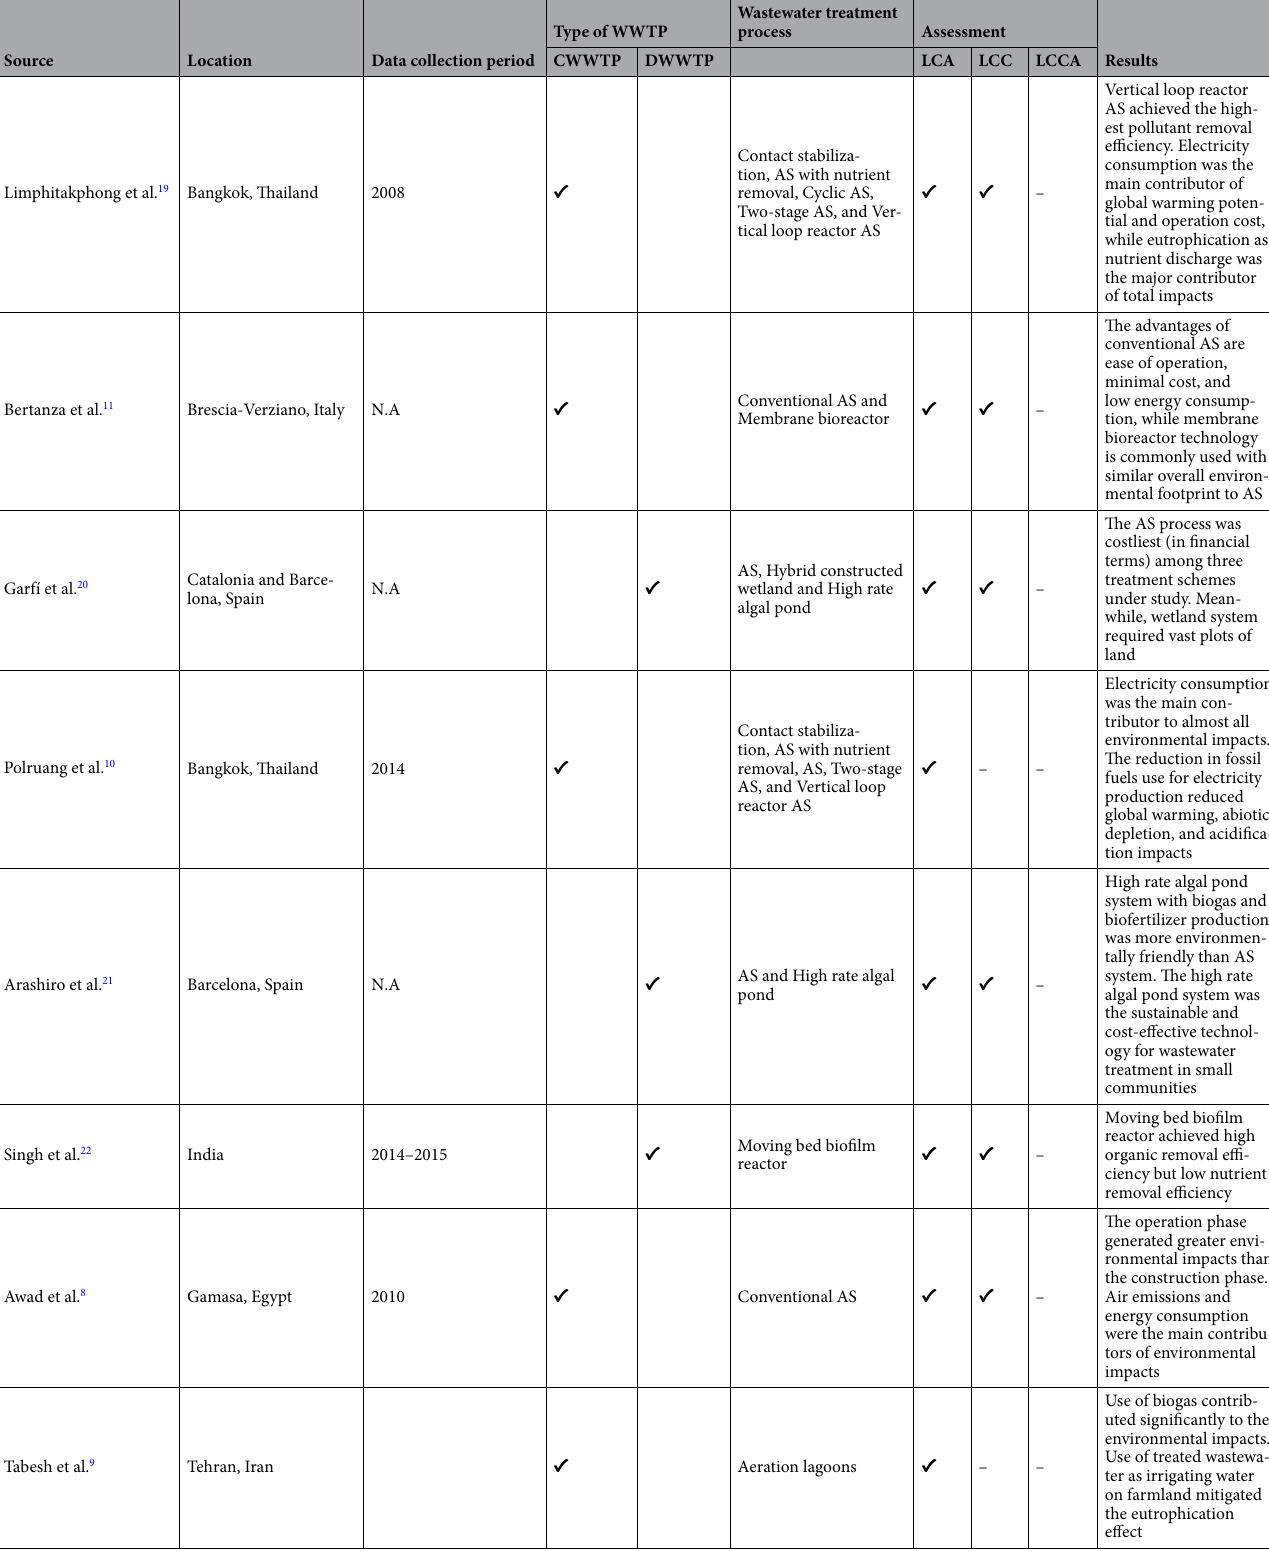
Table 1. Existing literature on LCA and LCC of centralized and decentralized WWTPs. Remark: N.A. denotes no available data. Note: The capacity of centralized WWTPs is more than 2500 m 3 per